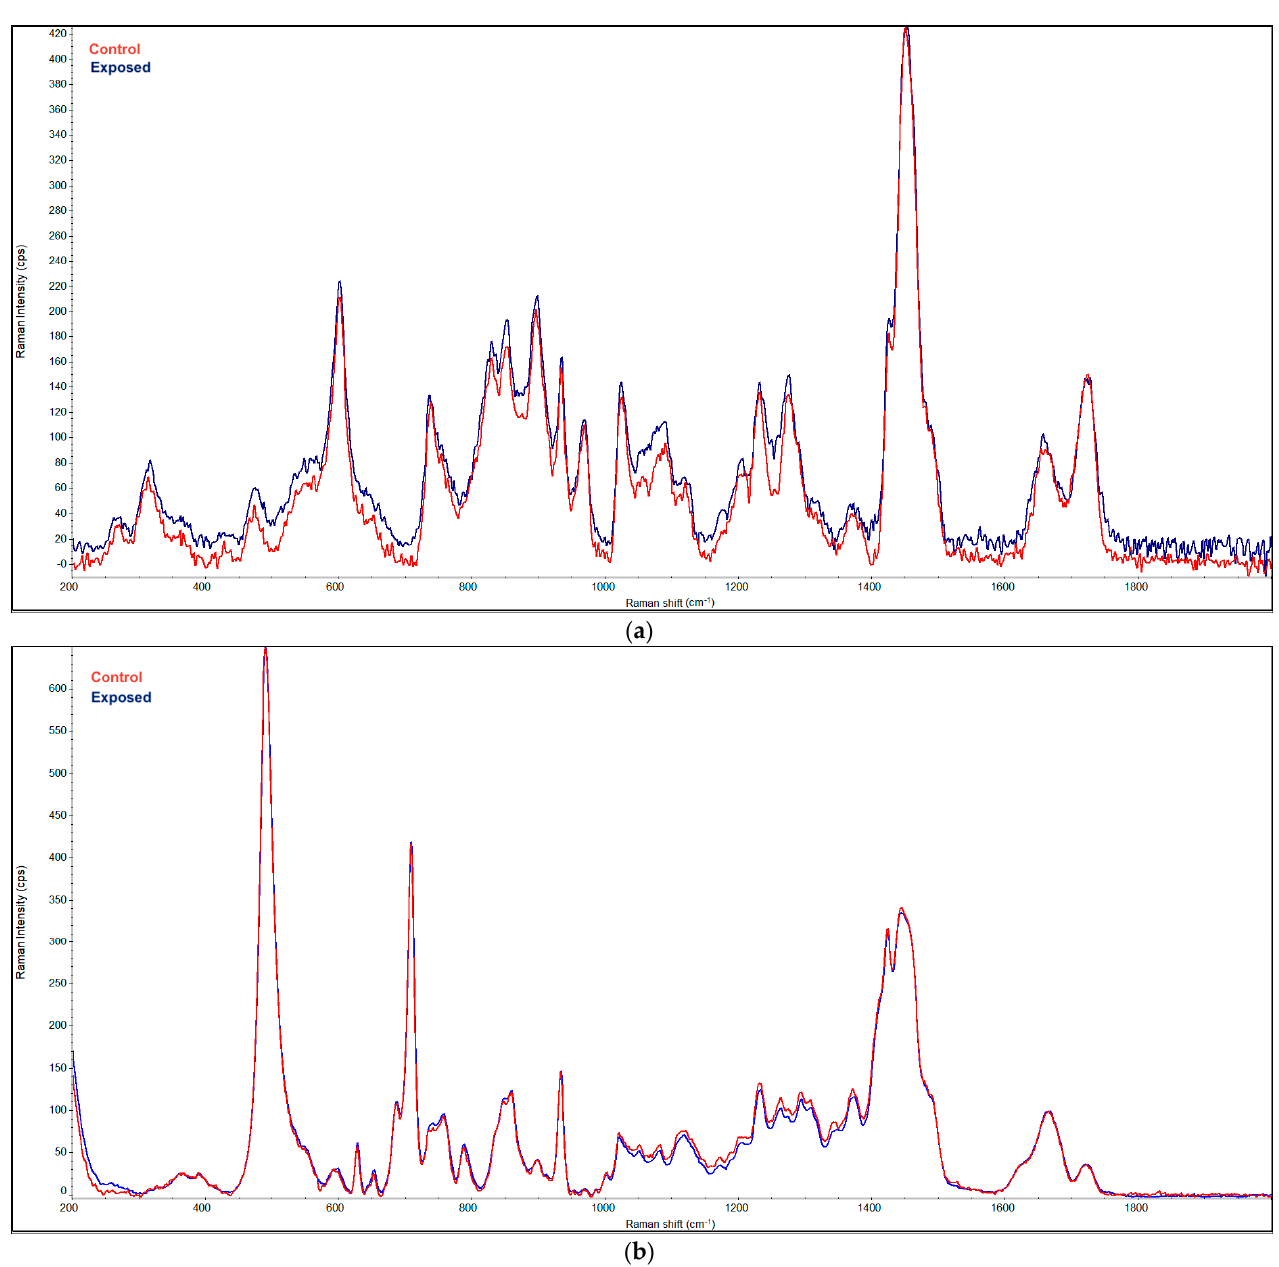
Figure 3. Cumulated Raman spectra of Soflens ( a ) and Biofinity ( b ) lenses before and after plasma exposure for 90 min.